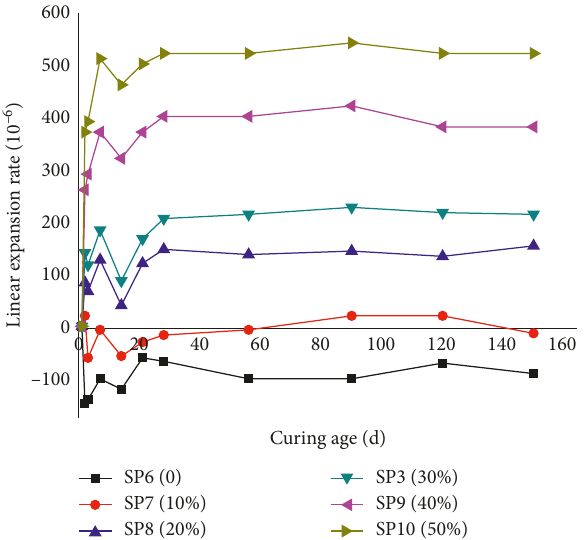
2 is hexagonal plate; gypsum is clavate.